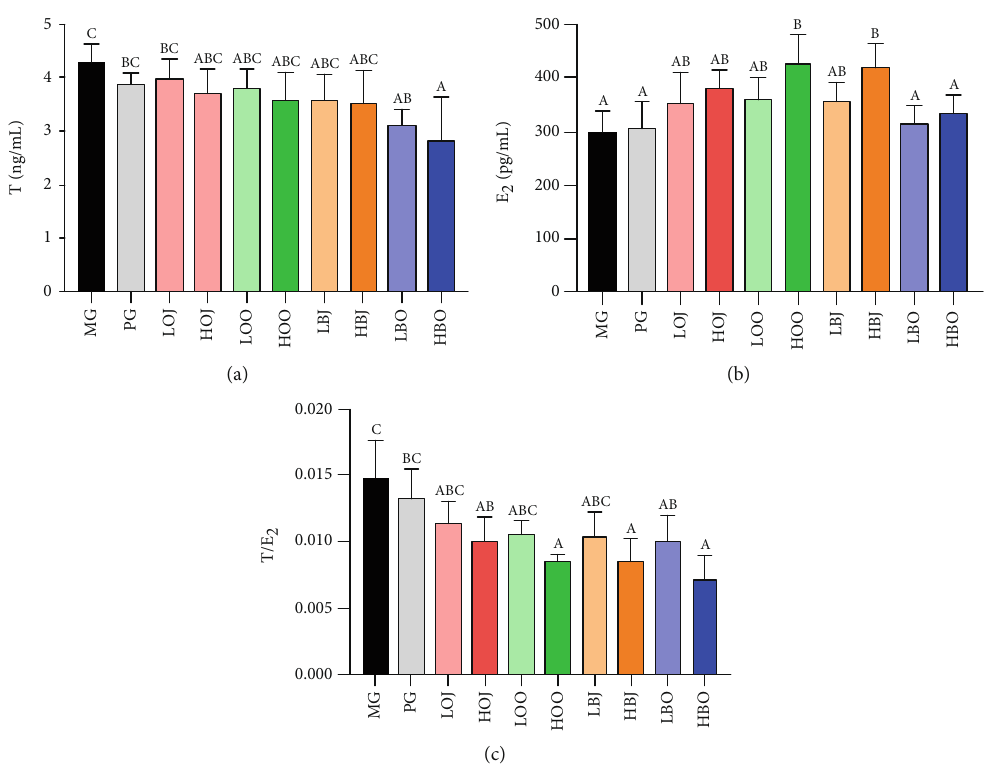
Figure 2: E ff ect of di ff erent treatments on serum sex hormone levels: (a) serum T level, (b) serum E expressed as the mean ± SD ( n = 8 ). Signi fi cance was de fi ned as P < 0 : 05 .